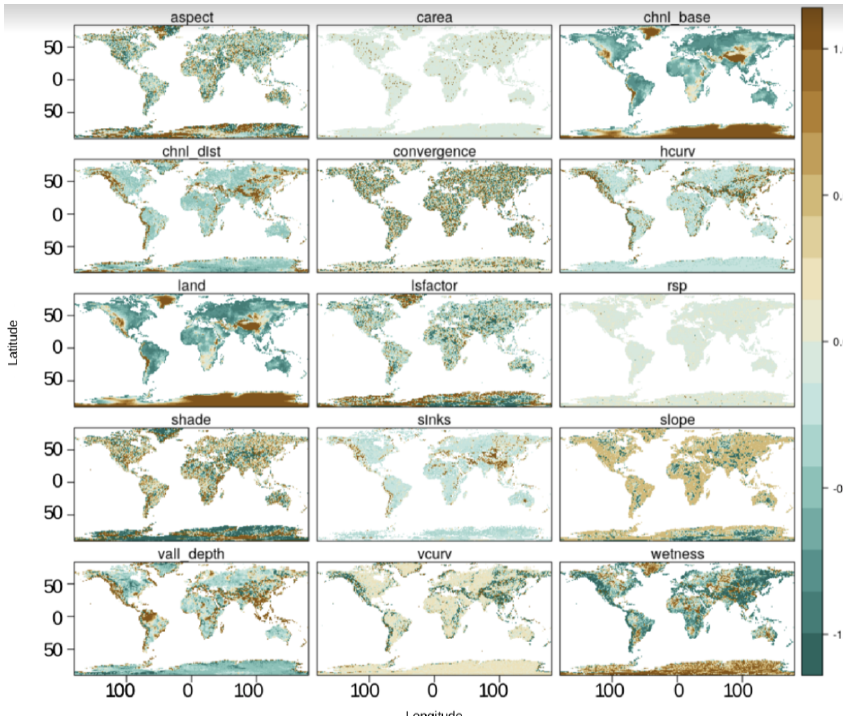
Figure 2. Digital terrain parameters used as prediction factors for soil moisture. These parameters are derived from a digital elevation model using SAGA-GIS. These terrain parameters are standardized by centering their means to zero and a variance unit for visualization purposes. Legend: (a) terrain aspect (aspect), (b) specific catchment area (carea), (c) channel network base level (chnl base), (d) distance to channel network (chnl dist), (e) flow convergence index (convergence), (f) horizontal curvature (hcurv), (g) digital elevation model (land), (h) length– slope factor (lsfactor), (i) relative slope position (rsp), (j) analytical hillshade (shade), (k) smoothed elevation (sinks), (l) terrain slope (slope), (m) valley depth index (vall depth), (n) vertical curvature (vcurv), and (o) topographic wetness index (wetness). For a detailed description and units of these parameters see Guevara and Vargas